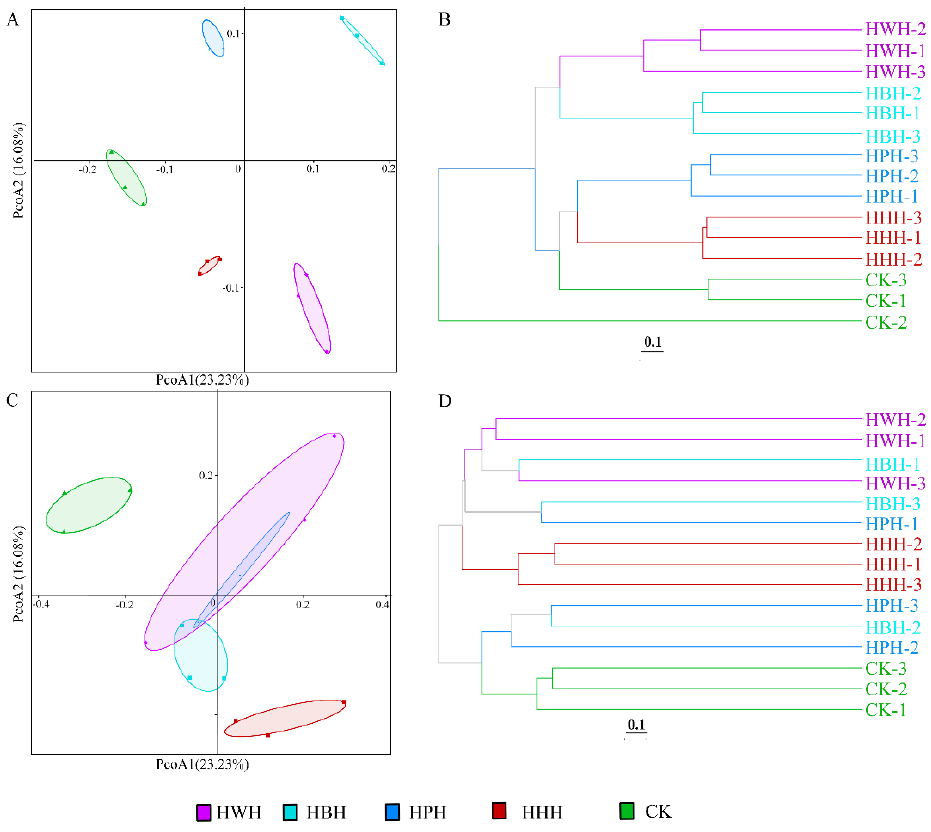
Figure 4. PCoA and UPGMA analyses of bacterial ( A , B ) and fungal ( C , D ) community structure. Based on PCoA analysis and Unweighted Pair Group Method with Arithmetic mean (UPGMA) of the binary Jaccard algorithm.